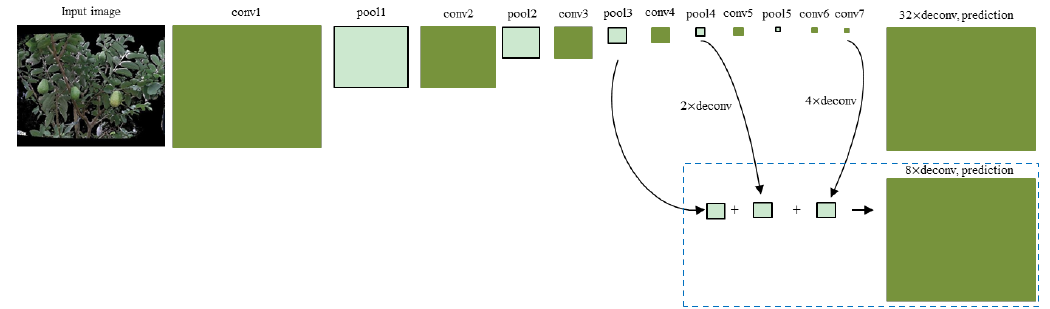
Figure 3. Fully convolutional network (FCN) configuration. The first row uses a deconvolution stride of 32, resulting in a coarse prediction. The second row fuses the outputs from the conv7 layer, the pool3 layer, and the pool4 layer at stride 8, leading to a finer prediction. The deconvolution parameter is defined as ‘(stride) × deconv’.